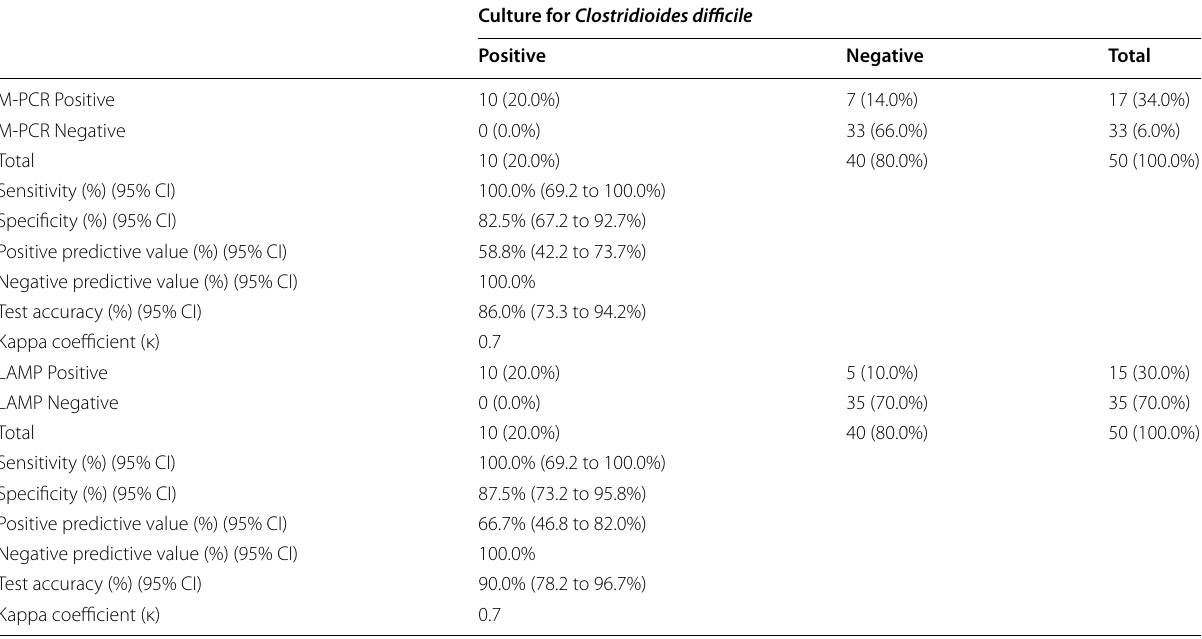
Table 4 Test performance of the multiplex polymerase chain reaction (M-PCR) and loop mediated isothermal amplification (LAMP) in detection of Clostridioides difficile isolates compared to the culture method Culture for Clostridioides difficile